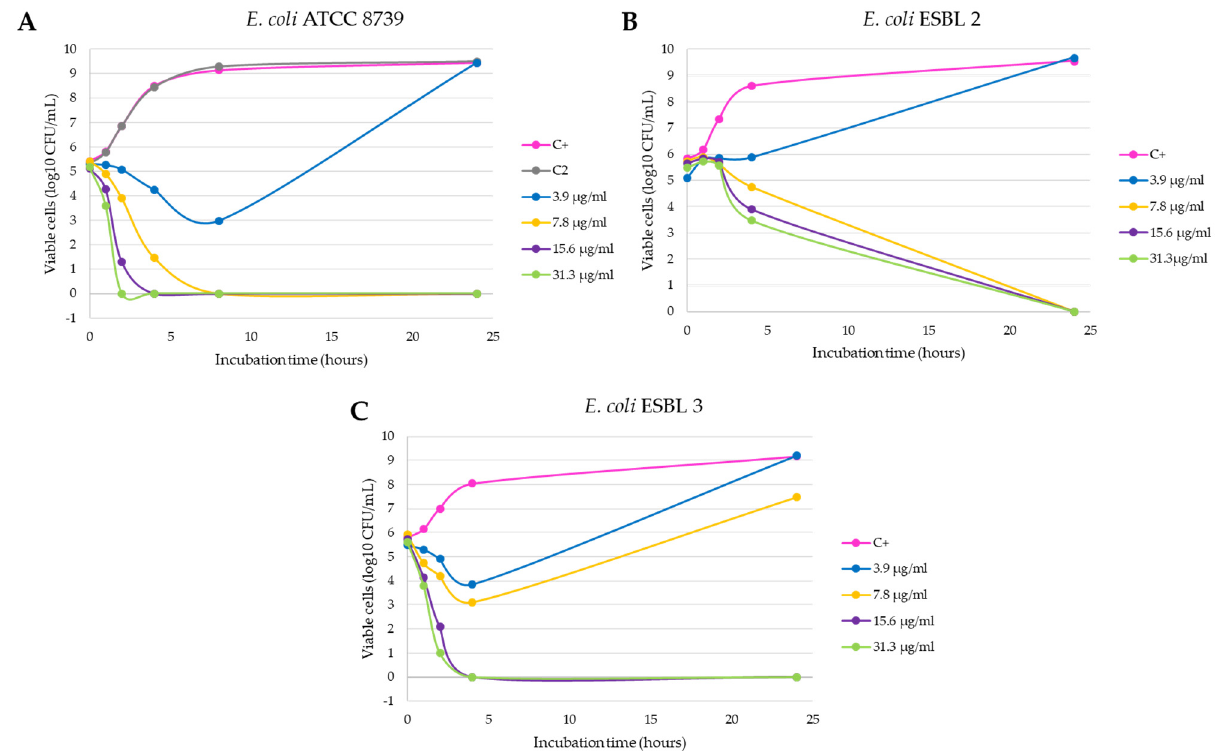
Figure 2. Inhibition curves of product C3-L1 in liquid medium against the Gram-negative strains E. coli ATCC 8739 ( A ), E. coli ESBL 2 ( B ) and E. coli ESBL 3 ( C ).